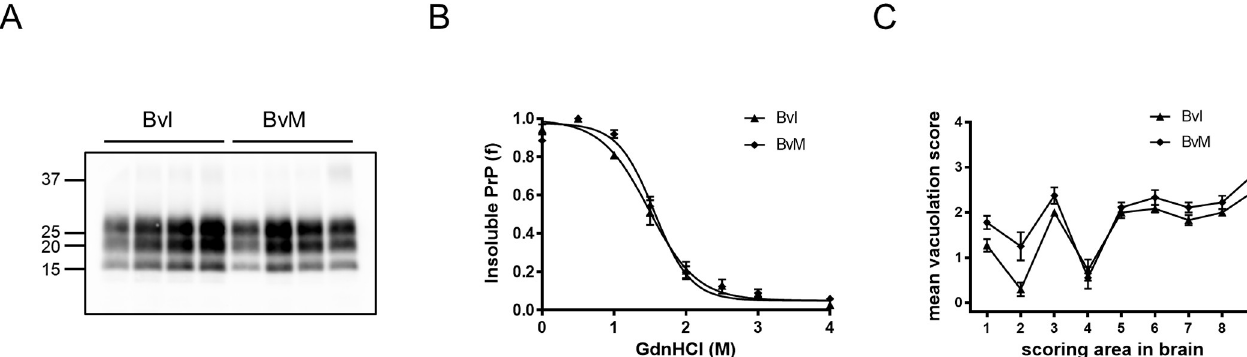
Fig 3. Neuropathological and PrP Sc phenotypes induced by the mixed case after passage in BvI and BvM. (A) Representative western blot showing PK- treated PrP Sc from brains of Bv inoculated with the mixed case emerged in BvI. The recipient model is indicated on the top of the blot. The positions of MW markers are indicated on the left of the blot (in kilodaltons). Membrane was probed with 9A2 monoclonal antibody. (B) The conformational stability of PrP Sc was analyzed by denaturation with increasing concentration of GdnHCl, followed by a solubility assay. The fraction of insoluble PrP Sc was plotted as a function of GdnHCl concentration (M) and best-fitted and using a four parameter logistic equation. Error bars represent the SEM of data from analyses of at least three animals per group. (C) Comparison of lesion profiles in BvI and BvM infected with the mixed case. Data points represent the mean ± SEM of at least five voles per group. Brain-scoring areas: medulla [1], cerebellum [2], superior colliculus [3], hypothalamus [4], thalamus [5], hippocampus [6], septum [7], retrosplenial and adjacent motor cortex [8], and cingulate and adjacent motor cortex [9].